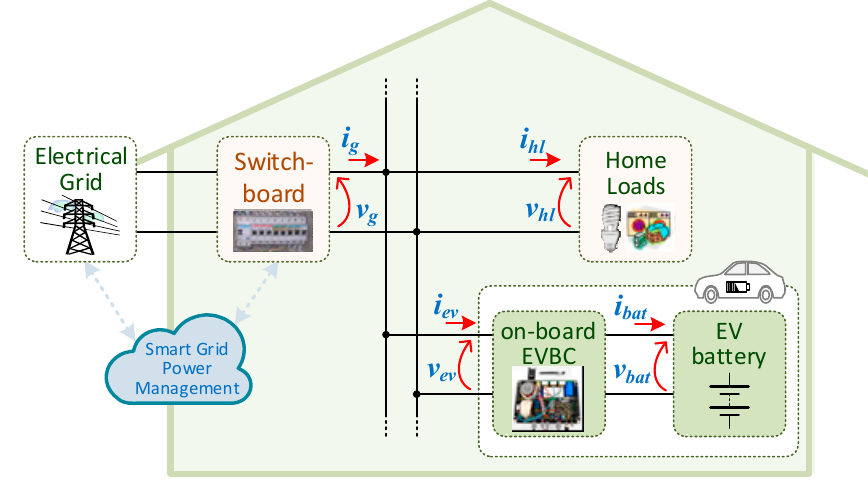
Figure 3. Illustration of the integration of an on-board EVBC into a smart home.